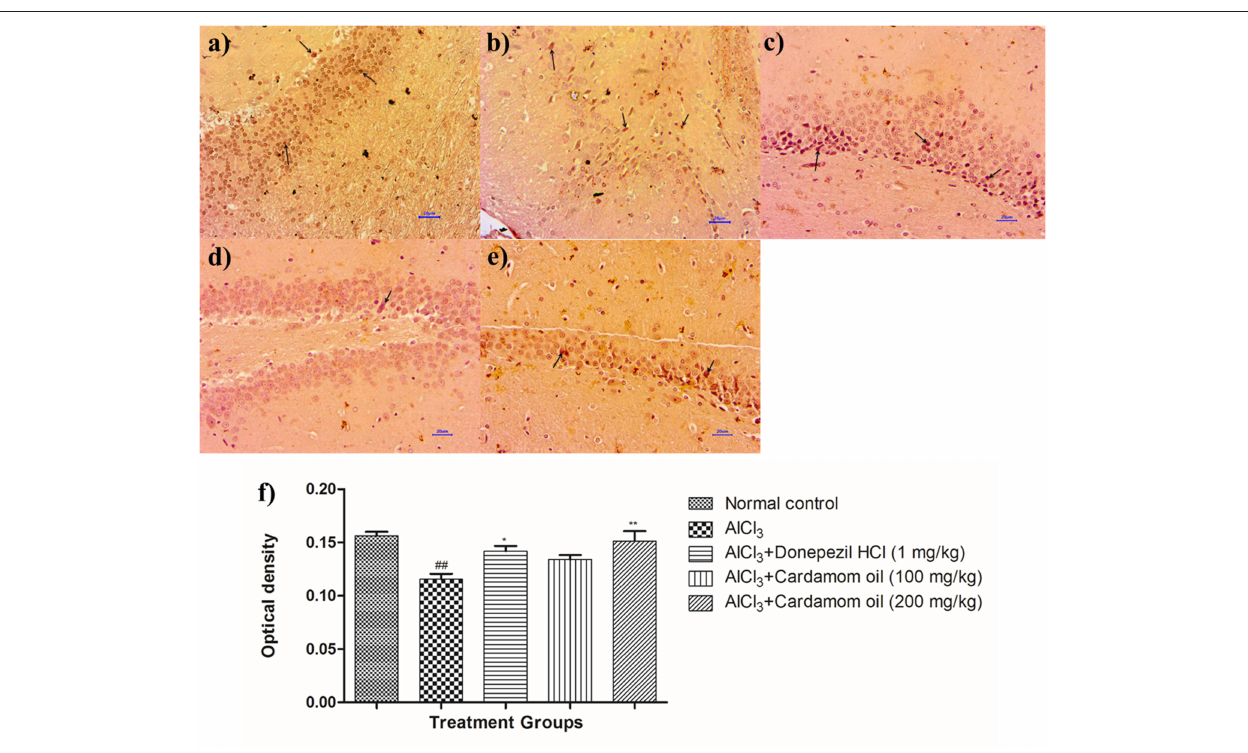
FIGURE 11 | Effect of cardamom oil on BDNF expression in hippocampus tissue (400X). (a) Normal control: Hippocampus: showing mild enhanced expression of BDNF, exhibited by brown coloration at hippocampal neurons (arrow) {Immunostaining: BDNF, 400X}, (b) AlCl 3 group: Hippocampus: showing reduced expression of BDNF, exhibited by brown coloration at hippocampal neurons (arrow) {Immunostaining: BDNF, 400X}, (c) AlCl 3 + Donepezil hydrochloride (1 mg/kg): Hippocampus: showing moderately enhanced expression of BDNF, exhibited by brown coloration at hippocampal neurons (arrow) {Immunostaining: BDNF, 400X}, (d) AlCl 3 + Cardamom oil (100 mg/kg): Hippocampus: showing reduced expression of BDNF, exhibited by brown coloration at hippocampal neurons (arrow) {Immunostaining: BDNF, 400X}, (e) AlCl 3 + Cardamom oil (200 mg/kg): Hippocampus: showing normal histology, mild enhanced expression of BDNF, exhibited by brown coloration at hippocampal neurons (arrow) {Immunostaining: BDNF, 400X}, (f) Histogram of IHC. Data are expressed as mean ± SEM ( n = 6), ## p < 0.01 when compared with normal control, ** p < 0.01, * p < 0.05 when compared with disease control group. The magnification was 400X. AlCl 3 , Aluminum chloride; SEM, Standard Error of Mean; BDNF, brain-derived neurotrophic factor; IHC,